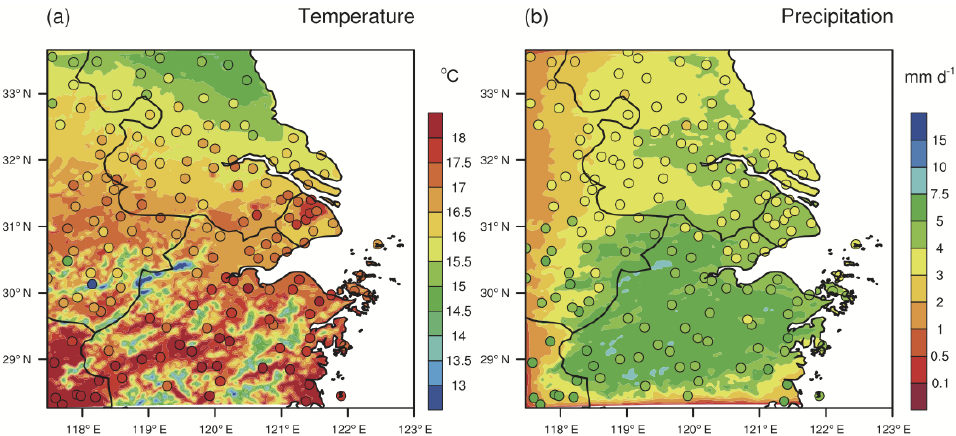
Figure 3. Annual mean (a) near-surface temperature (units: ◦ C) and (b) precipitation (units: mmd − 1 ) from observations (shaded circles) and the LU06E06 simulation (shaded).